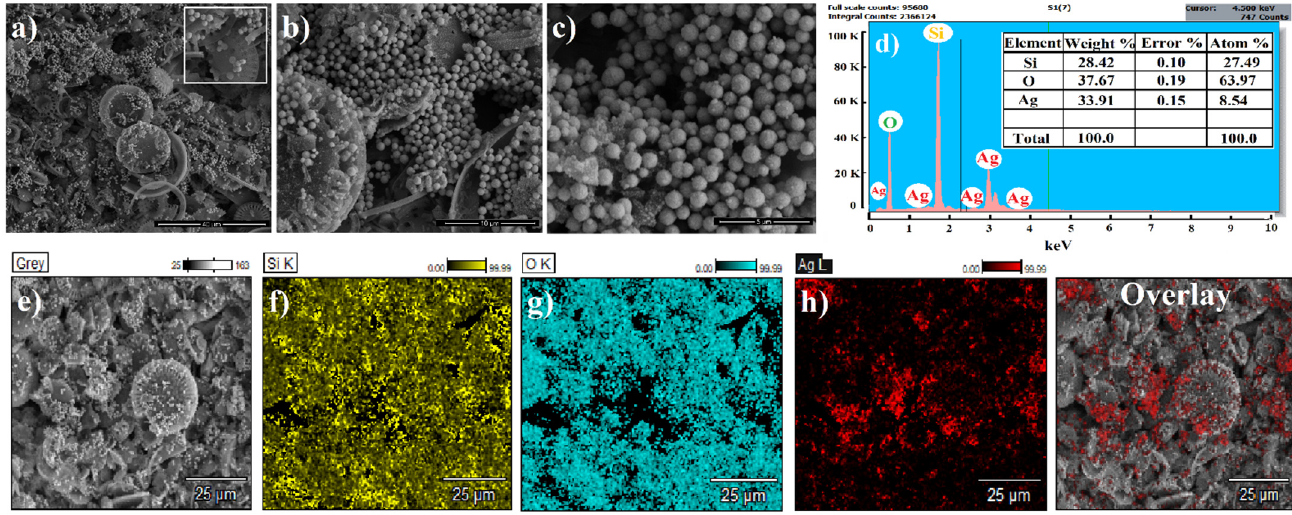
Figure 1. ( a – c ) SEM images of the fabricated AgNPs-DE SERS substrates acquired at different magnifications, ( d ) representative EDS spectrum and ( e – h ) Elemental mapping of the constituting com- ponents of the substrates. Si, O and Ag are the only contributing signals, while Si and O are scattered throughout the plane of view, Ag appears to be localized in small pockets. The unique color code yellow, cyan and red represent Si, O and Ag, respectively.